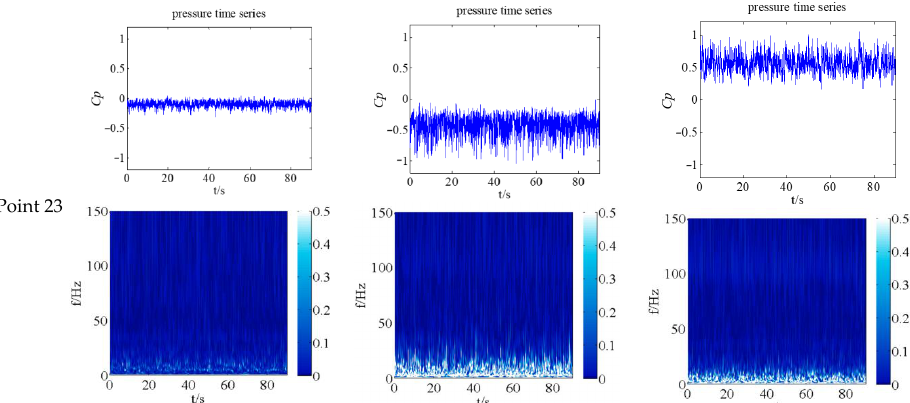
Figure 7. Morlet wavelet transform of wind pressure time-history in the boundary layer flow: ( a ) φ = 0°; ( b ) φ = 90°; ( c ) φ = 180°. To obtain more detailed data on the unsteady and low-frequency nature of the wind pressure on the building, the time-power and frequency-power characteristics of point 23 on layer H with a wind direction of 90 ° (Figure 8a) were investigated, as shown in Figure 8b,c. The global averaged wavelet power spectra are depicted in Figure 8b. This figure shows the distribution of the average wavelet power spectra over the entire time span in the frequency domain. We can see that the dominant frequency, the peak of the curve, is around 3 Hz, which is basically the same as the range reported by [33]. The scaled, averaged wavelet power spectra are depicted in Figure 8c; this figure demonstrates the distribution of scale-weighted average wavelet power spectra over the entire scale span in the time domain and can be used to measure the global intensity of the pressure pulsations over time. It can be seen that the wavelet power spectrum pulsates intensively over time. This indicates that the energy of the unsteady pressure loads changes rapidly in a short time span.